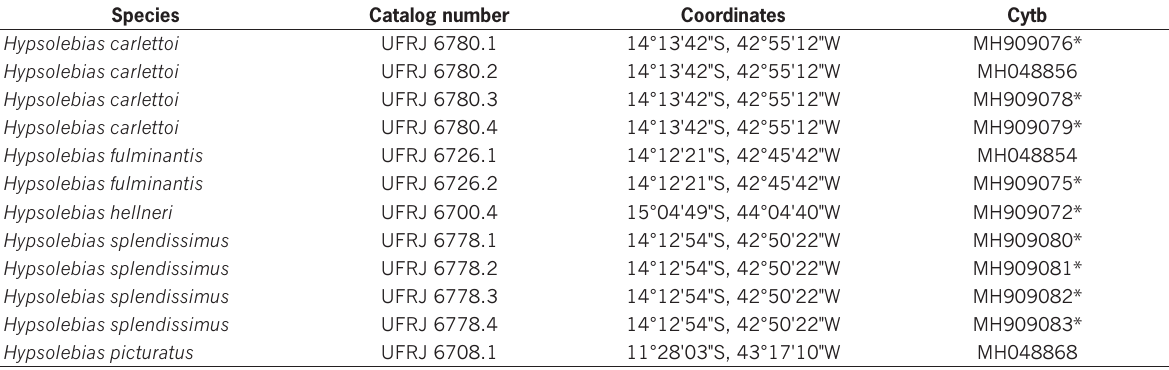
Table 1. List of specimens used in the molecular analysis, with their respective catalog numbers, coordinates of the collecting site, and GenBank accession numbers for cytb sequences. Asterisk indicates sequences not published